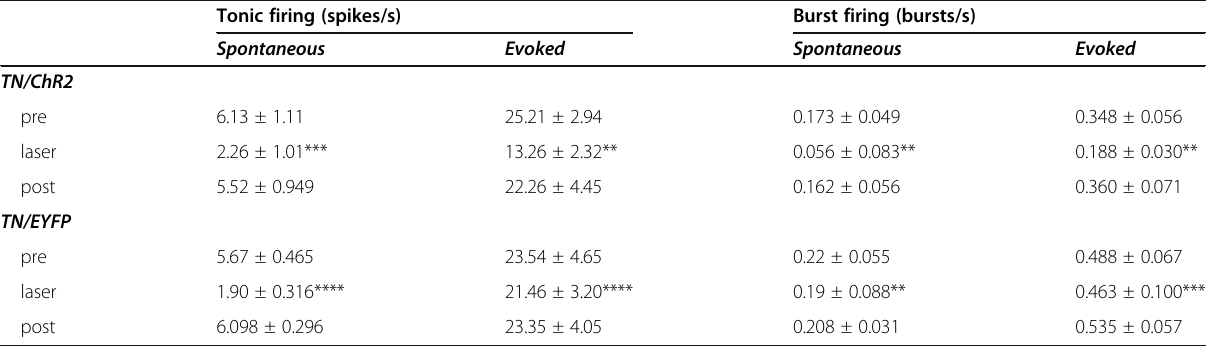
Table 3 Spontaneous and evoked firing rates of VPM thalamic neurons in response to optic stimulation of vlPAG